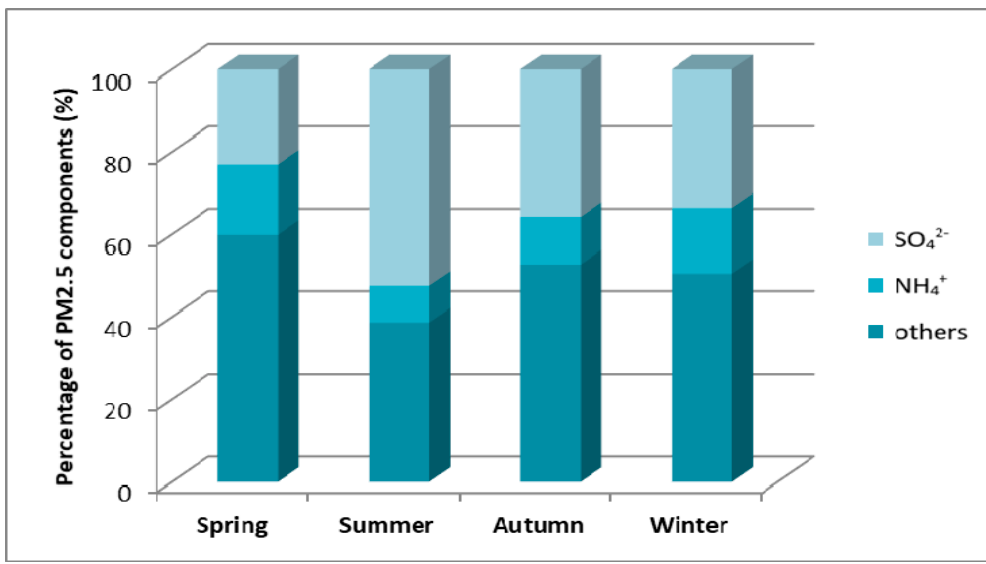
Figure 13. Mass percentage of PM2.5 components in particular seasons of 2010 in the monitoring station in Diabla Góra [23].